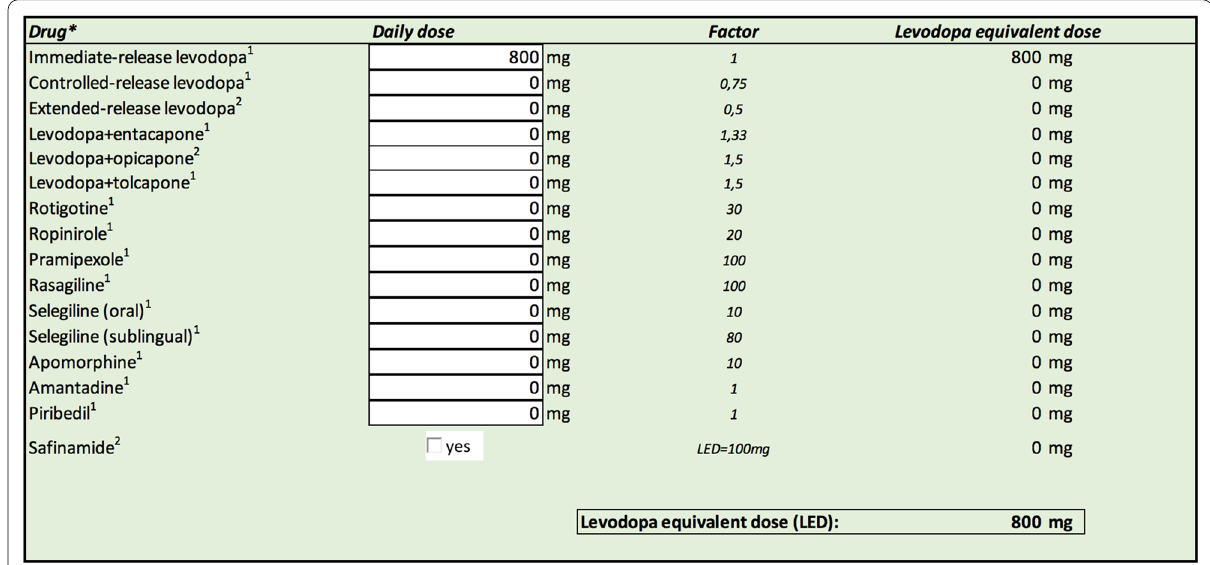
Fig. 1 Levodopa equivalent dose is calculated according to conversion factors and parameters reported elsewhere by submitting daily doses of commonly used anti-Parkinson drugs (single or in combination) [2, 4, 5]. Immediate-release levodopa 100 mg 8 times daily is given as an example.